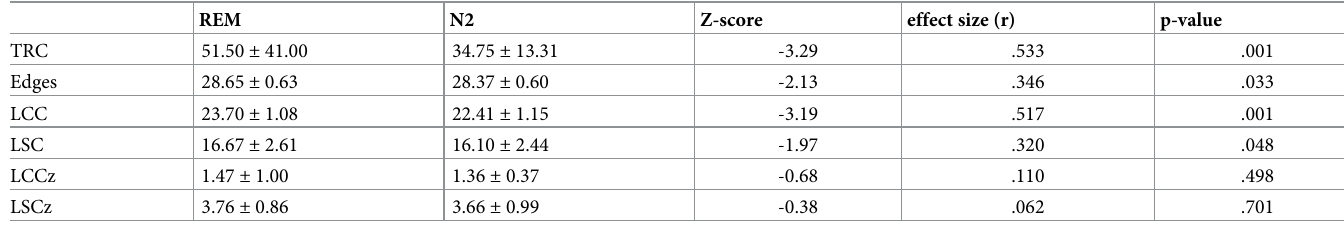
Table 1. Results from Wilcoxon sign-rank tests (n = 40).